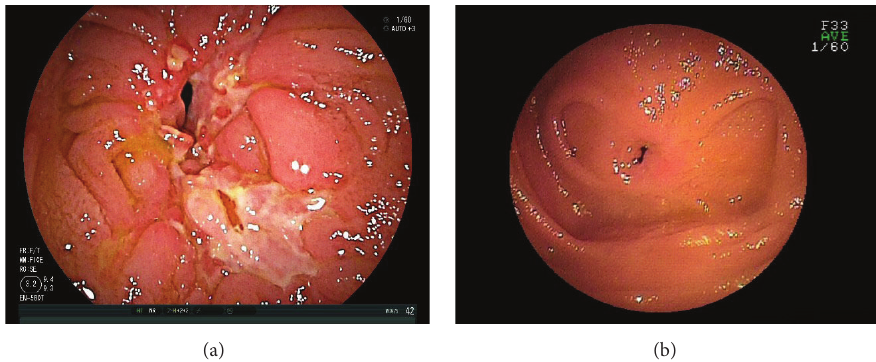
Figure 2: (a) Small bowel stenosis containing both fibrotic and inflammatory components. (b) Small bowel stenosis with